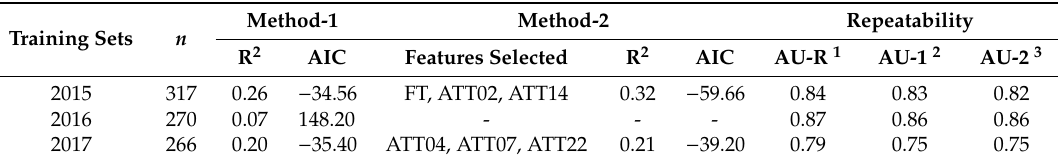
Table 2. Performance of the models for Fusarium head blight (FHB) severity under two di ff erent correction